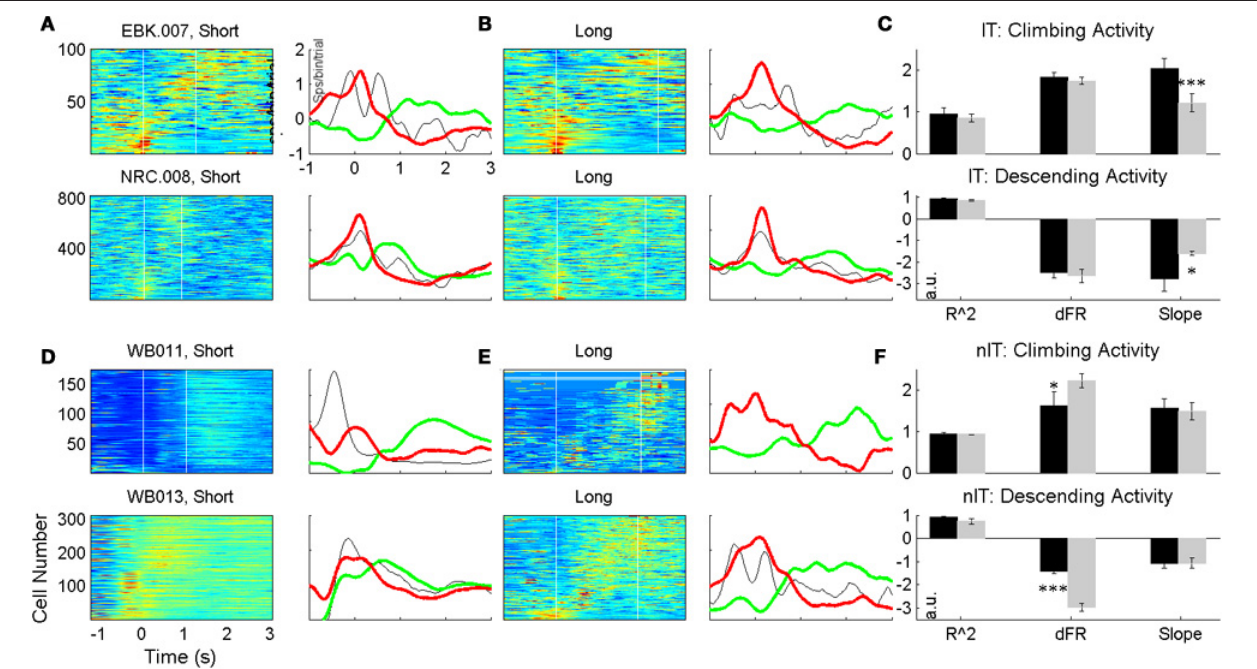
FIGURE 5 | Trial averaged ensemble modulations during short (A,D) and long (B,E) duration presses for IT (A–C) and nIT (D–F) animals. Average traces of climbing (green), descending (red), and other (black) activity shown to the right of each pseudocolor image. Qualitatively, slopes between press durations for IT animals seem different, while